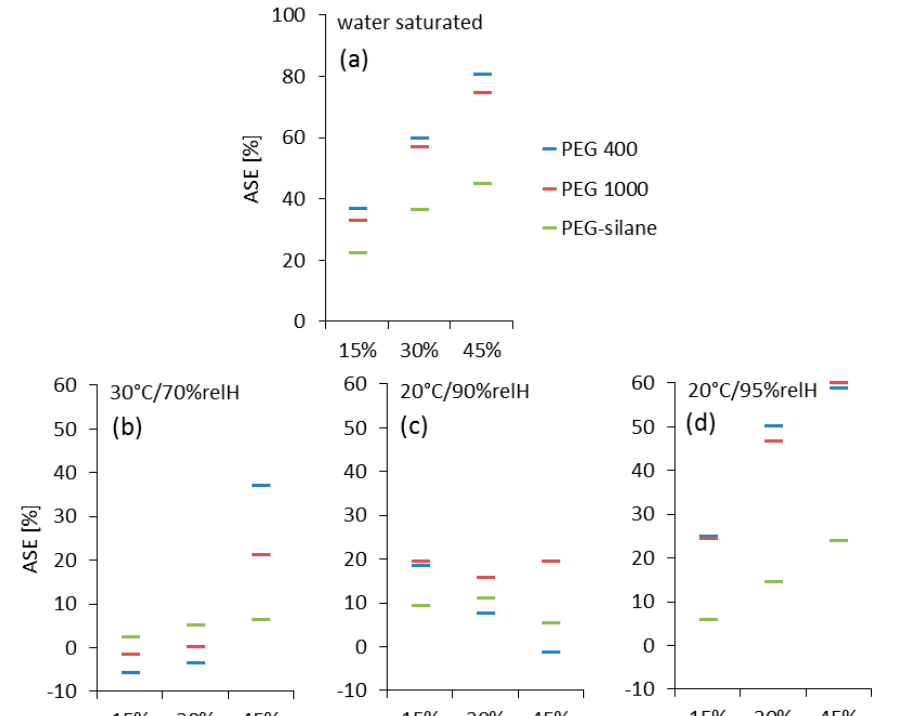
Figure 6. ASE values of treated oak wood in water saturated state ( a ) and different climate conditions ( b – d ), based on transversal swelling. The climate conditions in ( b , c ) correspond to approximately 11%, 16% and 20% wood equilibrium moisture content.